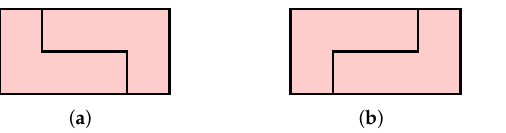
Figure 2. The two possible ways to tile R : ( a ) first tiling solution; ( b ) second tiling solution.